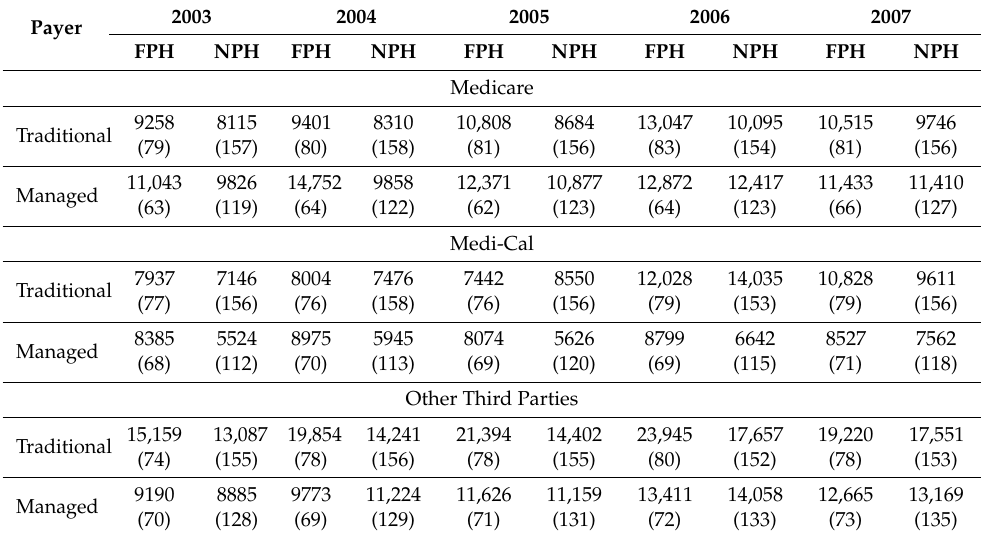
Table 7. Reimbursement by Payer